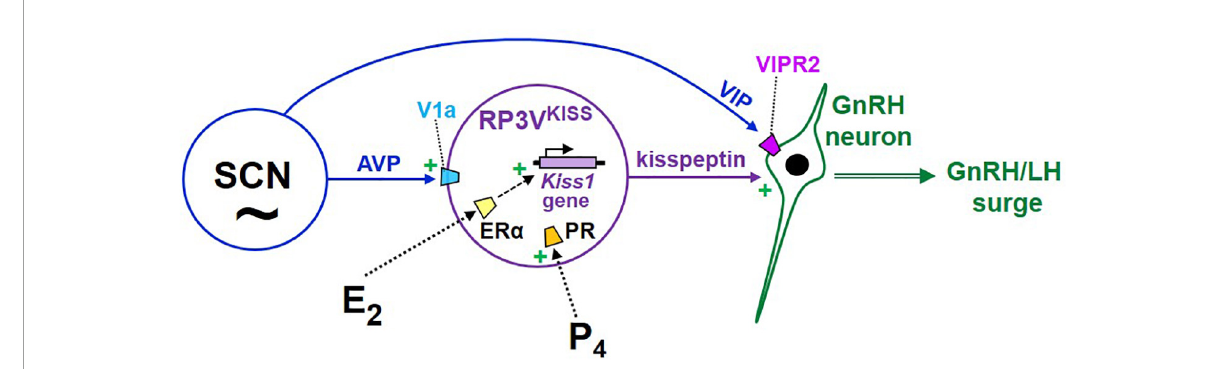
FIGURE4 Cartoon model of the proposed hypothalamic neural circuits regulating the E 2 -induced preovulatory LH surge in female rodents. Under this model, GnRH neurons are activated by upstream kisspeptin neurons in the RP3V, which are E 2 -sensitive and express both ER and PR. RP3V KISS neurons are themselves also influenced by both progesterone and circadian cues, the latter likely arising from the SCN, including vasopressin neurons. In addition, VIP neurons in the SCN project to GnRH neurons and may be involved in additional modulation of GnRH secretion during E 2 positive